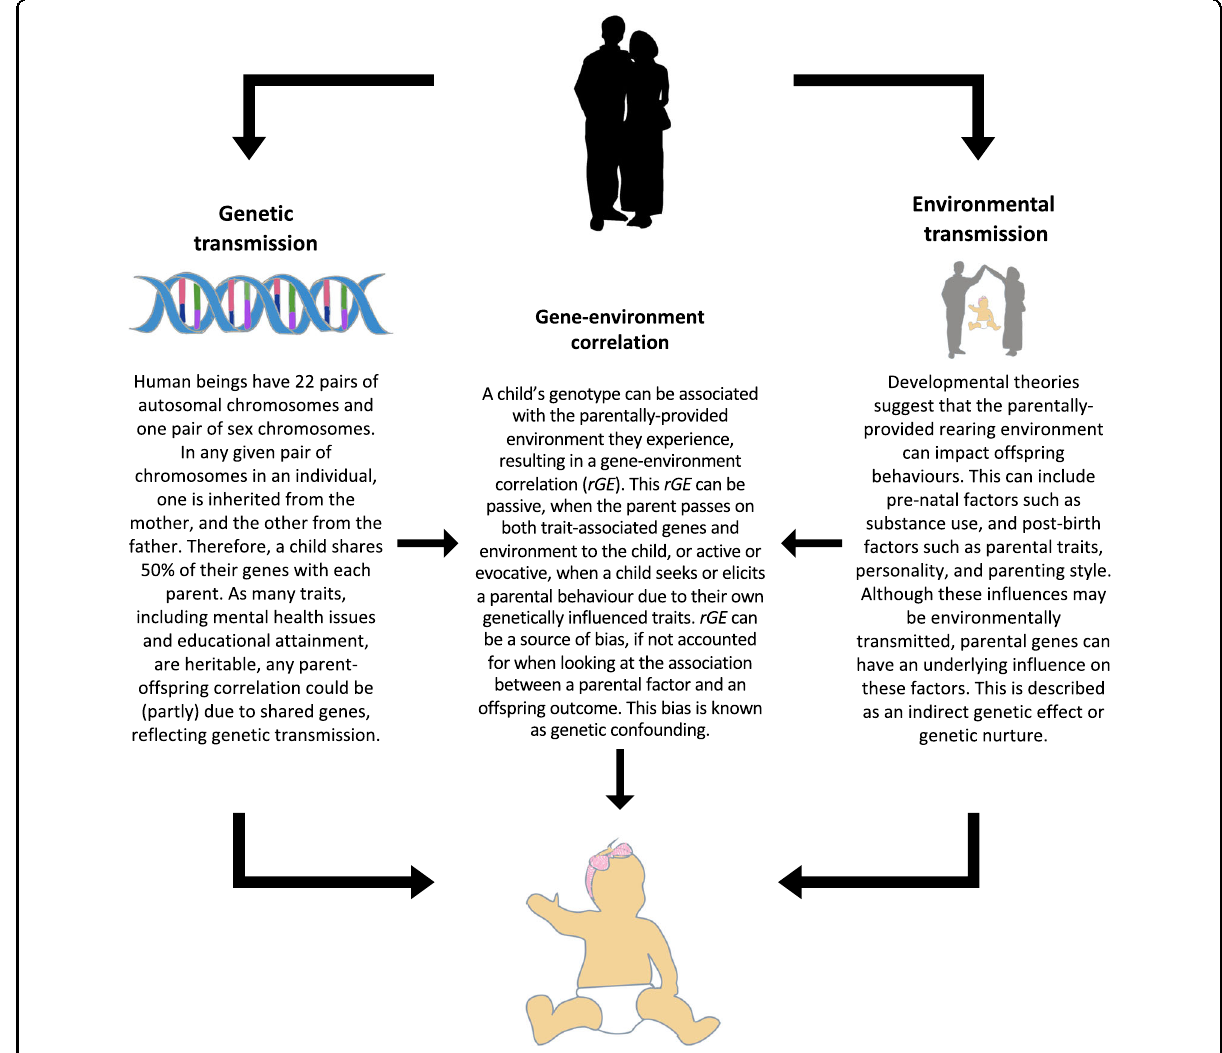
Fig. 1 Mechanisms underlying parent-offspring associations. A fi gure describing potential mechanisms (genetic transmission, environmental transmission, and gene-environment correlation) underlying associations between parental characteristics and offspring